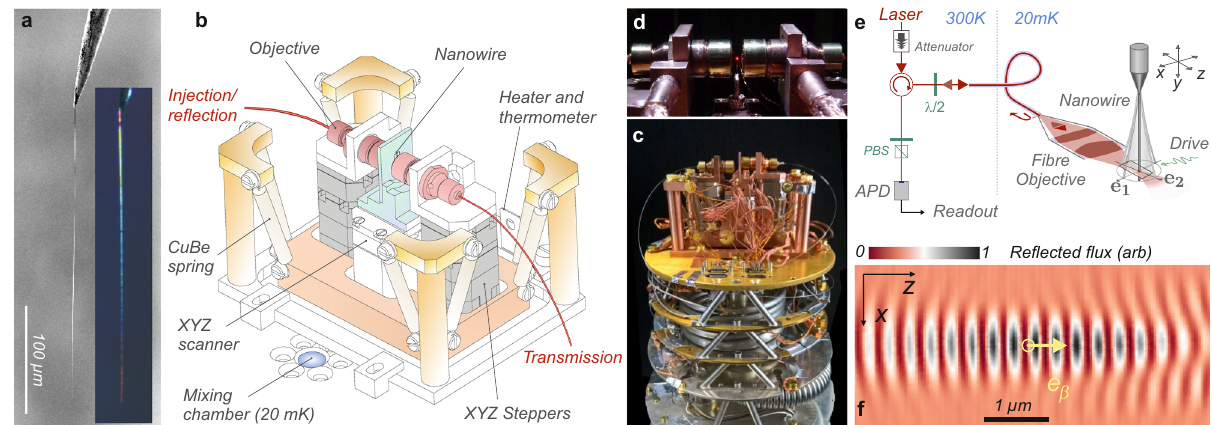
Fig. 1 Experimental setup. a SEM and optical images of the silicon carbide nanowires of large aspect ratios employed in this work. b , c Sketch and image of the experiment mounted on the cold plate of the dilution fridge: the light is fi ber guided to the suspended cryogenic experimental platform, and focused on the nanomechanical oscillator under investigation. d Close up of the optical apparatus also showing a fraction of the focused light scattered by the nanowire. e Sketch of the cryogenic interferometric readout. Part of the light is re fl ected on the output face of the monomode fi ber and interfere with the light back-scattered by the nanowire. f Moving the nanowire (2 μ m above its vibrating extremity) in the waist area, in the xz horizontal transverse plane, generates a very contrasted re fl ectivity map, where the phase curvature of the focused laser beam can be clearly identi fi ed.